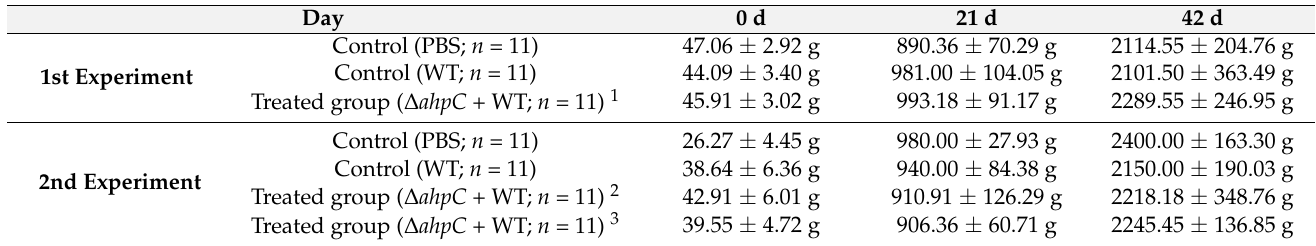
Table 1. Effects of pre-colonization with the ∆ ahpC mutant on body weight increase in